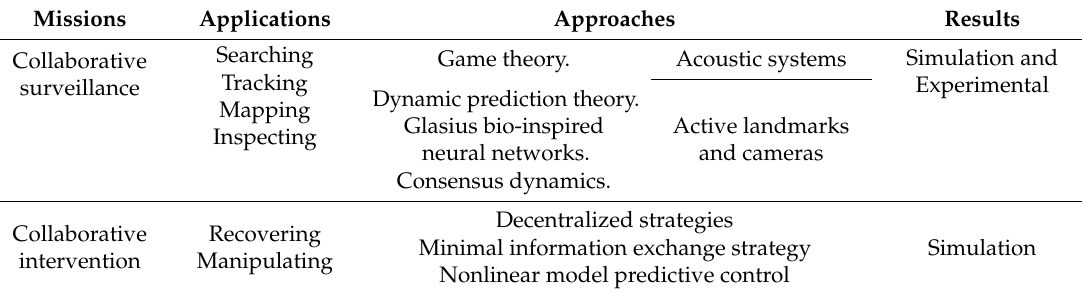
Table 6. Summary on collaborative AUV